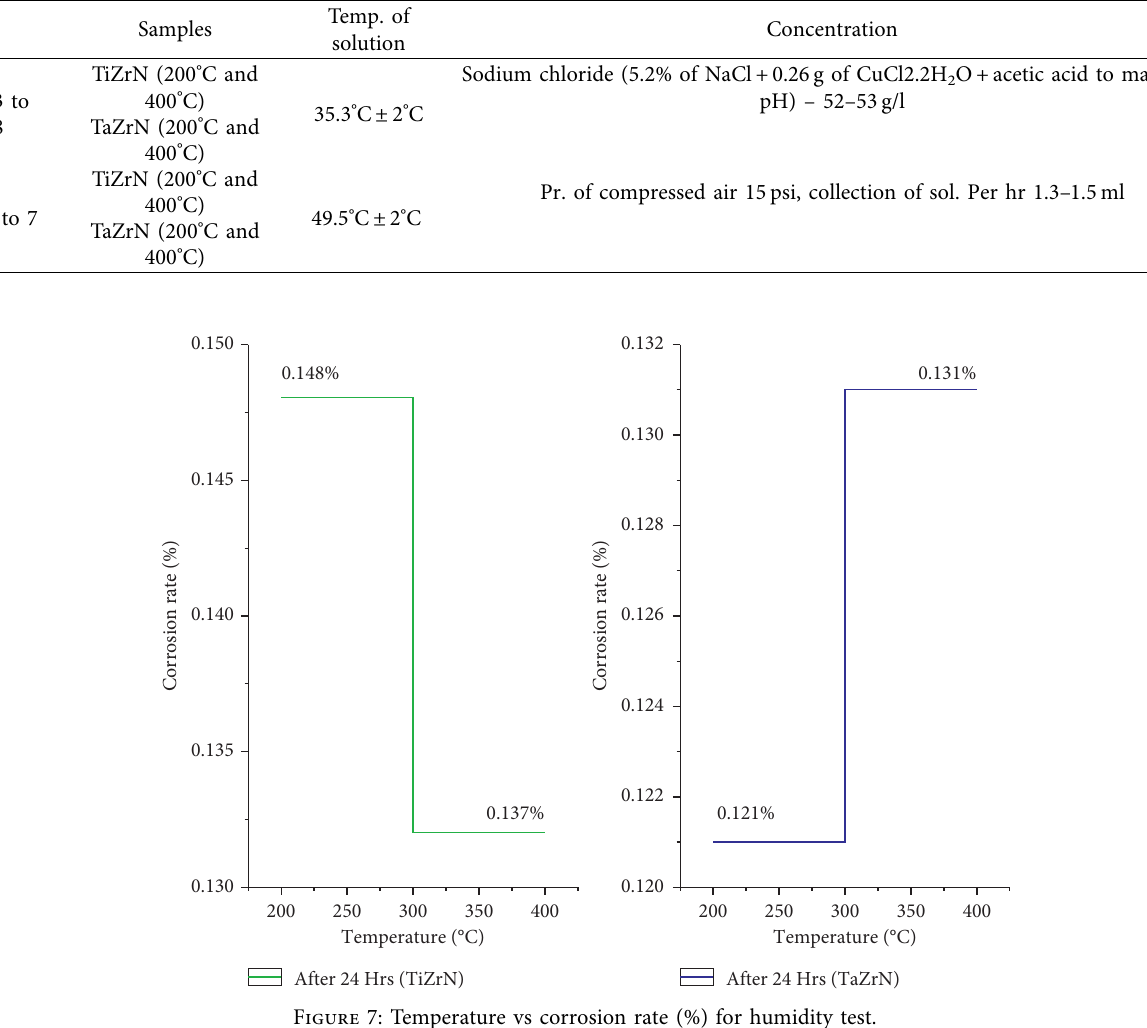
Table 5: Important parameters evaluated from the coated samples of TiZrN/TaZrN tested in salt spray ASTM B-117 (ISO 9227:2017 (CASS TEST)).